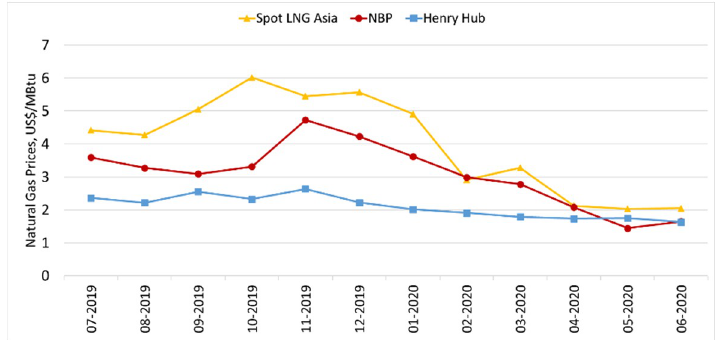
Figure 6. Daily variation of the price of natural gas [39].